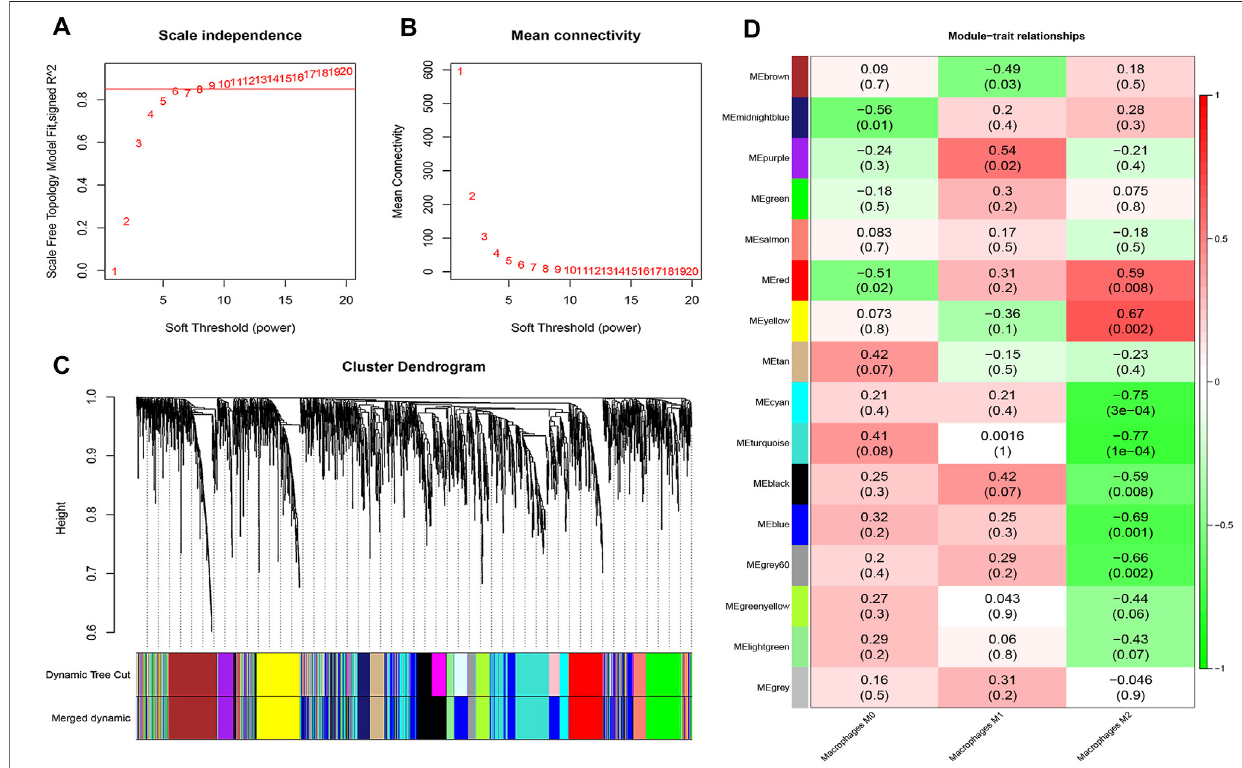
FIGURE 2 | Hierarchical cluster formation based on the soft threshold power ( β ). (A) Estimation of the scale independence index of the 1 – 20 soft threshold power ( β (cid:1) 9). (B) Determinationofthe meanconnectivity ofthe 1 – 20 softthresholdpower. (C) Identi fi cation and establishment ofgeneco-expressionmodulesthat areshown as different colors in hierarchical clustering. (D) Relationships of consensus module eigengenes and M ϕ . The rows in the fi gure correspond to consensus modules, and the columns correspond to macrophage subtypes. The numbers in each module indicated the correlation coef fi cients to show the association between the corresponding module and M ϕ , along with the p values shown below in parentheses (red indicates a positive correlation and green indicates a negative